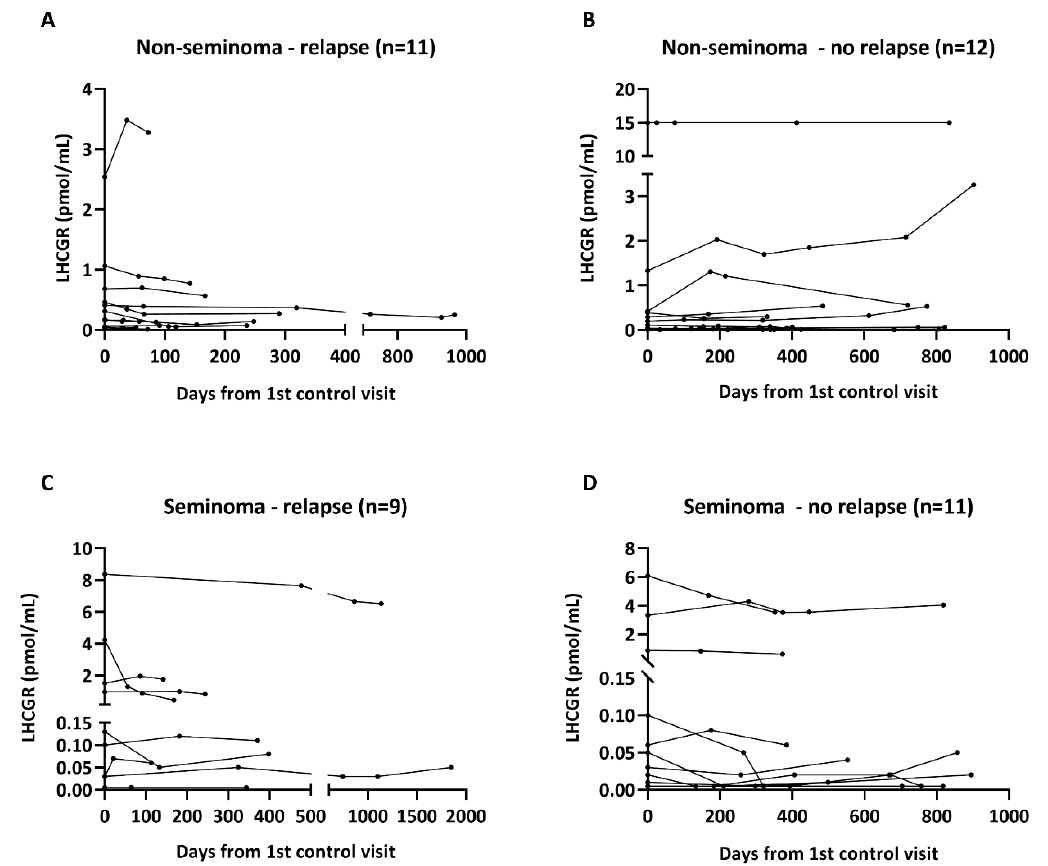
Figure 5. Serum LHCGR in TGCT patients with and without relapse. LHCGR serum levels were measured in patients with non-seminoma ( A , B ) and seminoma ( C , D ) who were followed longitudinally until they experienced a relapse or were released from the follow up period. Abbreviations: LHCGR, luteinizing hormone/choriogonadotropin receptor.